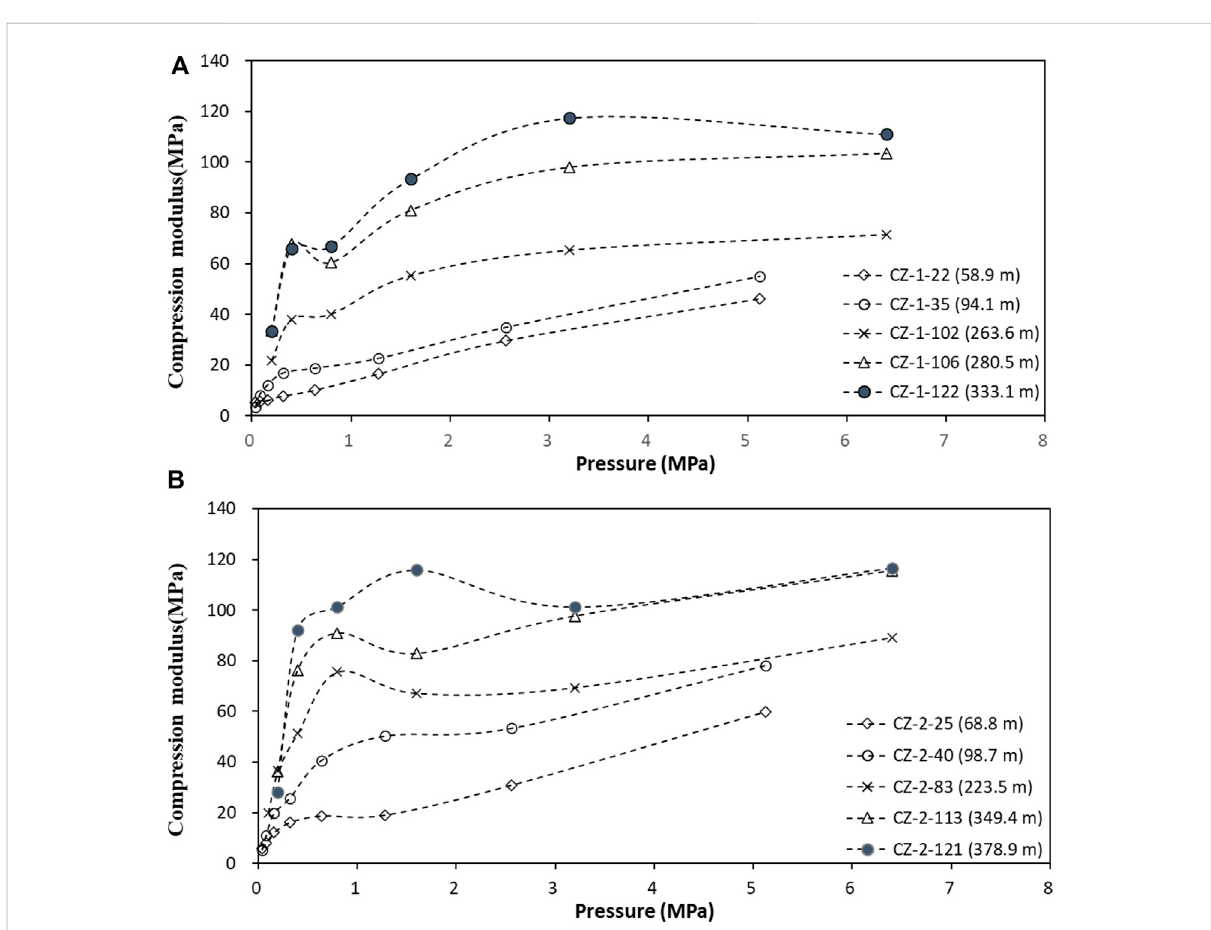
FIGURE 5 Compression modulus of soil samples at different depths in boreholes CZ-1 (A) and CZ-2 (B) as a function of pressure.